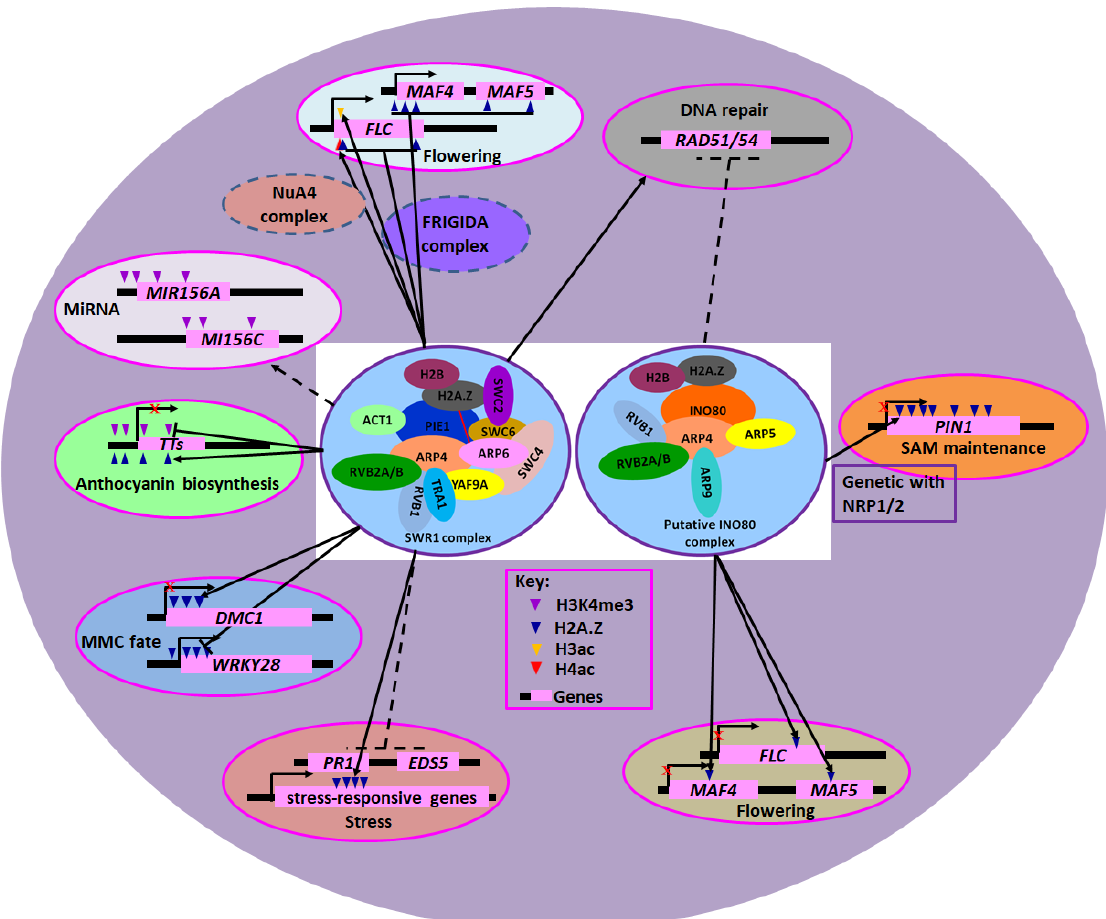
Figure 1. INO80 and SWR1 Chromatin Remodeling Complexes in Cellular Processes and Plant Development. The compositions of putative INO80 and SWR1 complex are indicated. The purple oval represents the nucleus of plant cells. The overlapped ovals and red lines represent interacting subunits of the INO80 and SWR1 complex. Lines with perpendicular bars and red cross denote repression, while arrows indicate enhancement or activation. Broken lines indicate relationships not proven to be direct.